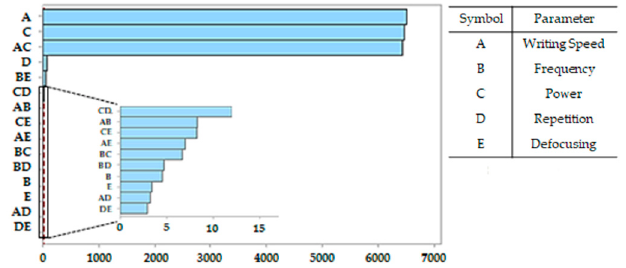
Figure 2. Pareto plot showing the relevance of different parameters and their combinations on the conductivity of tracks.